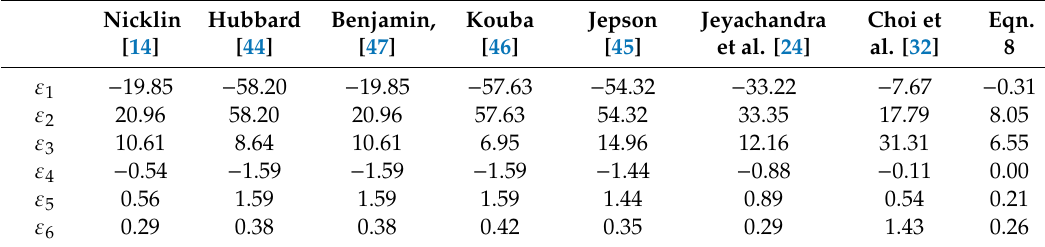
Table 3. A comparison between our proposed and existing